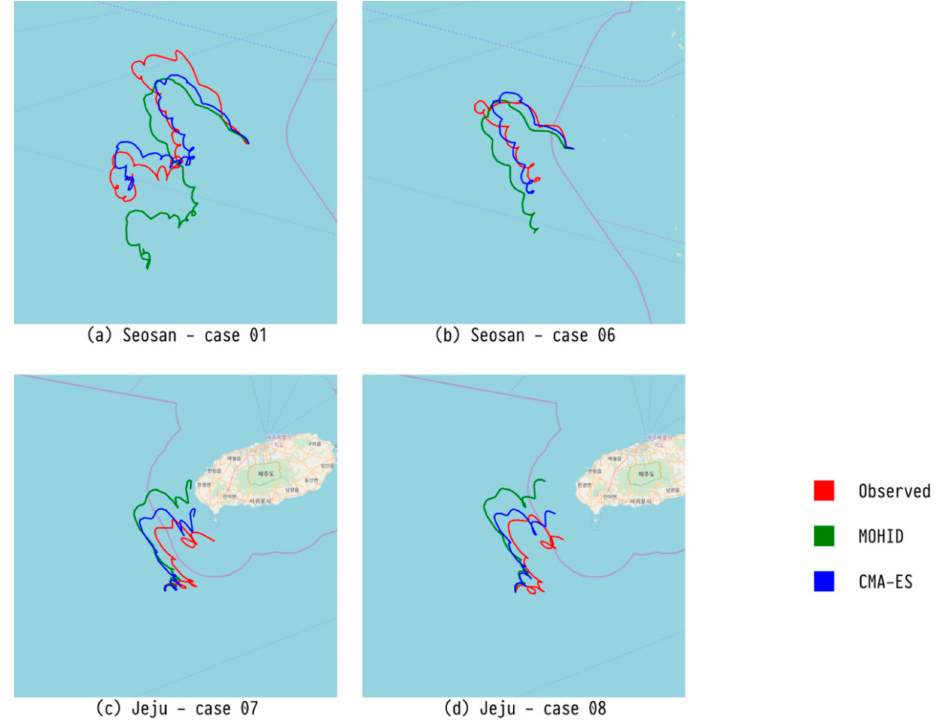
Figure 8. Comparison of trajectory predicted by our CMA-ES model, trajectory predicted by an existing numerical model (MOHID), and observed trajectory for four major